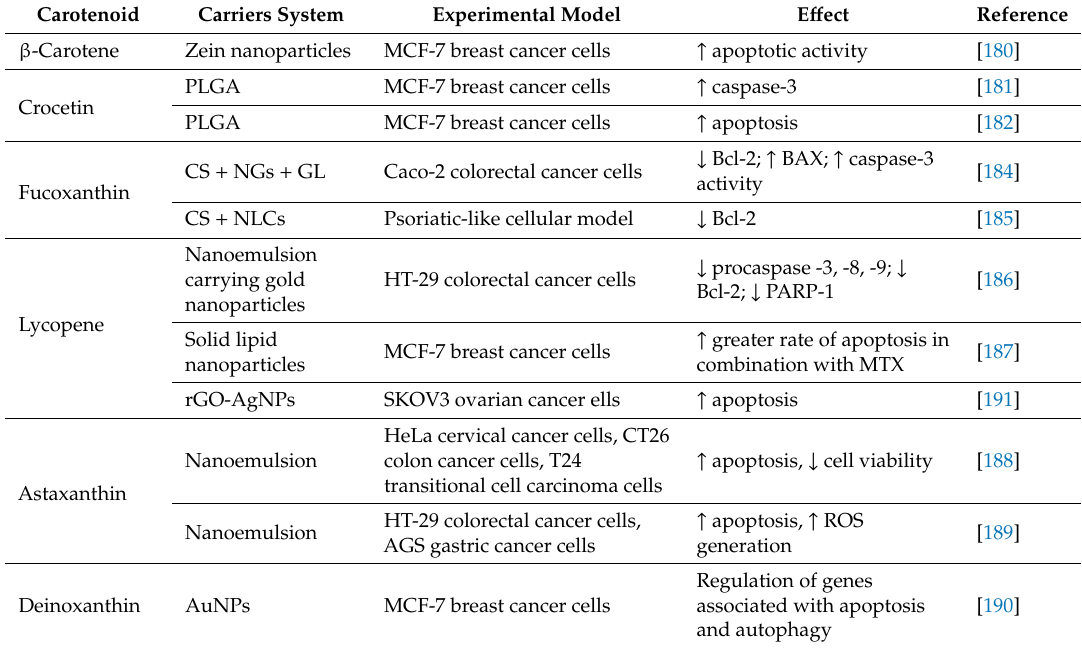
Table 3. An overview of studies focused on carotenoids combined with nanotechnologies and their impact on the modulation of